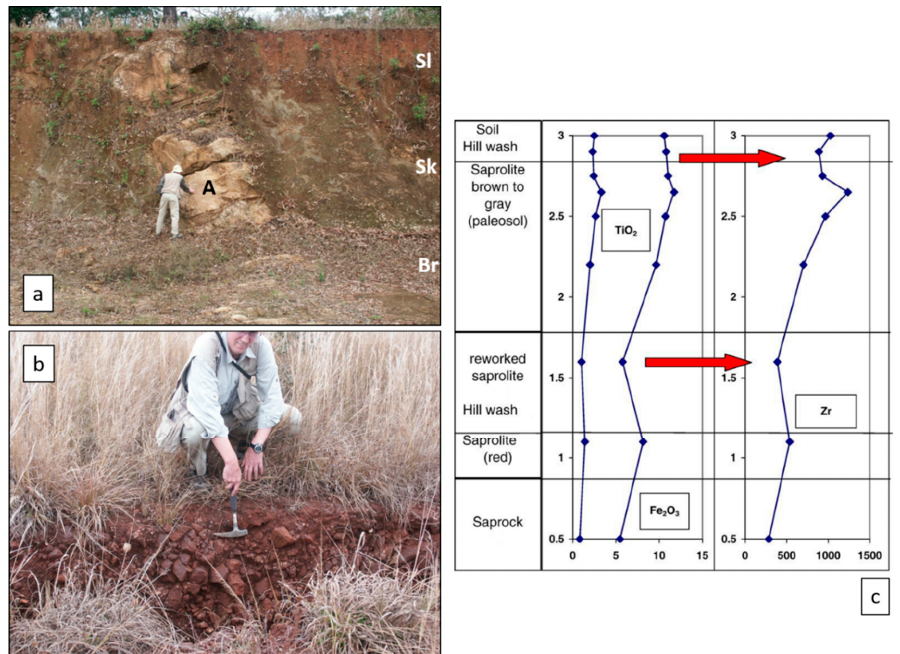
Figure 2. Residual placers from the savannah in Malawi. ( a ) Penetration of weathering as a function of bedrock lithology. The migmatitic K gneiss (Br) is more susceptible to weathering than the aplitic dyke (A) producing a weathering mantle of saprock (Sk) and saprolite (Sl). The meteoric fluids easily penetrated the metamorphic rocks along the planes of foliation which are very narrowly spaced and almost vertical. ( b ) Rusty red saprolite with relic corestones of metapyroxenite. The weathering loam hosts pale green and white sapphire crystals disseminated in a case-hardened duricrust. ( c ) Chemolog along a road cut measuring 3 m in depth illustrating the transition from a residual placer to a colluvial placer. Rutile (see TiO 2 contents) and zircon (see Zr contents) are cast in the role of marker minerals. The dip-slope motion of the weathering material is denoted by the red